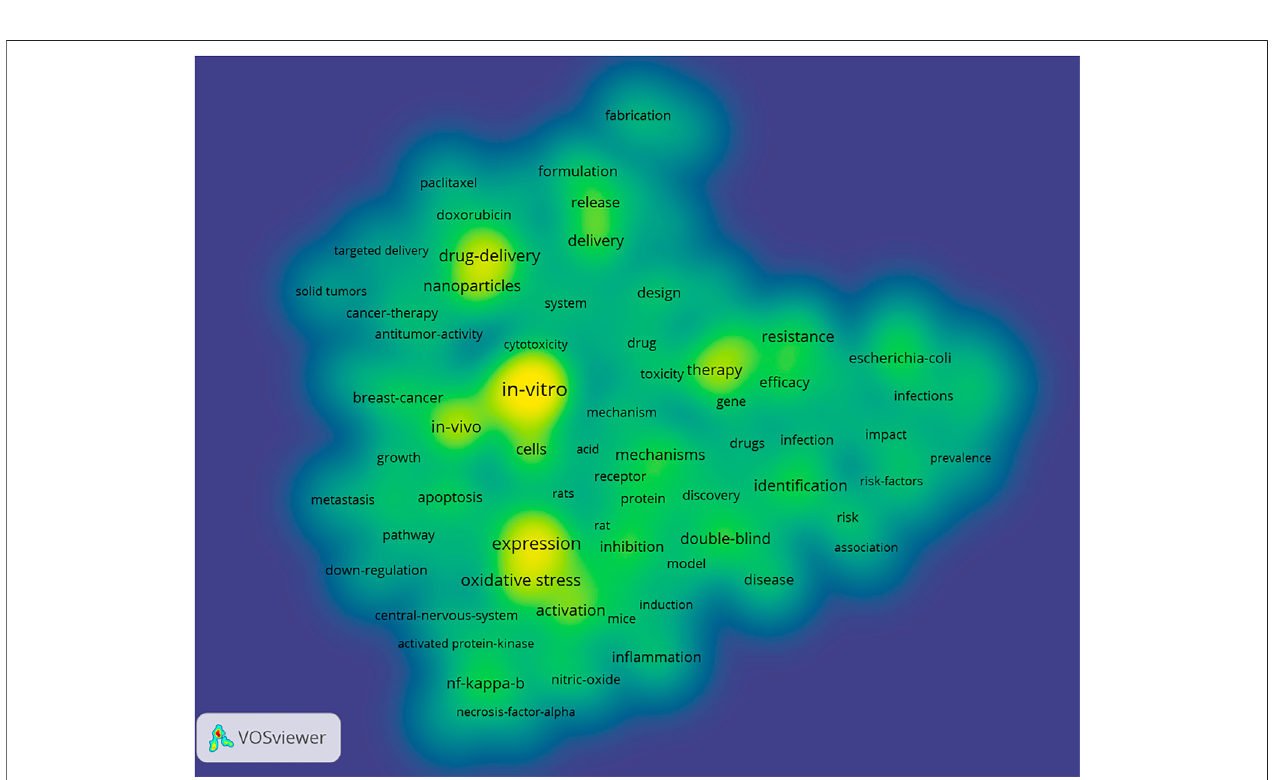
FIGURE 8 | Heatmap of subject terms of high-impact studies in pharmacology and pharmacy research.